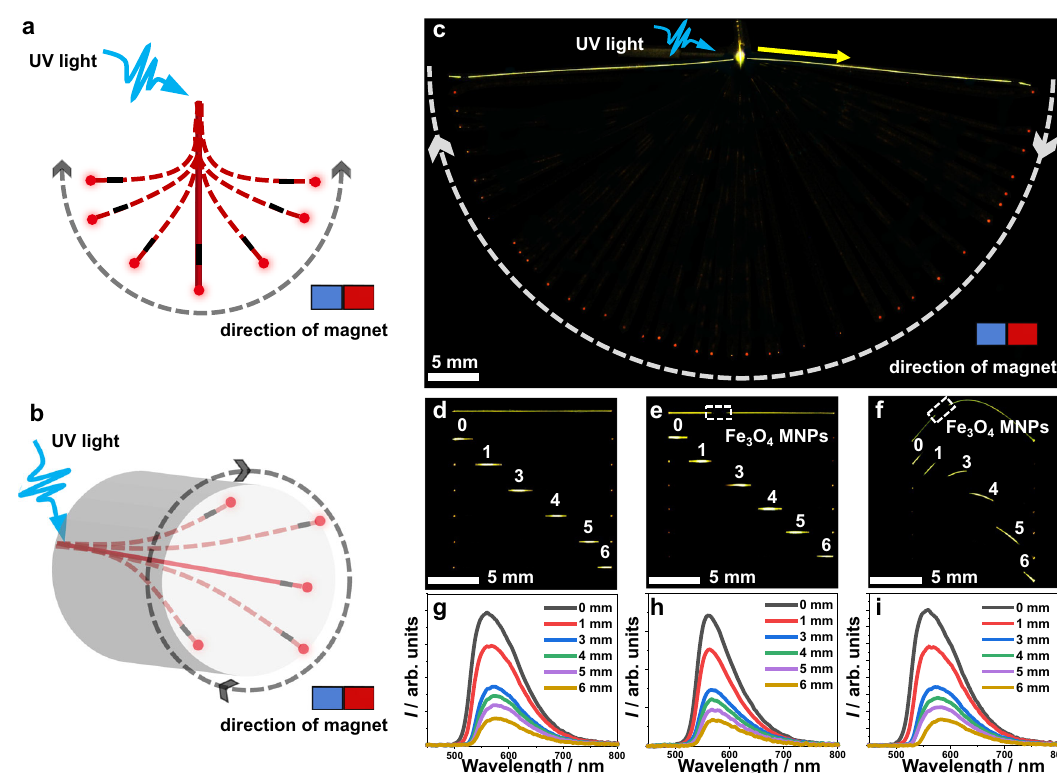
Fig. 4 Hybrid organic crystals as magnetically controllable organic crystal optical waveguides. a , b Schematic of the experiments that demonstrate control over the shape of a crystal as optical waveguide by using magnetic fi eld in two dimensions ( a ) and in three dimensions ( b ). The grey arrow represents the direction of movement of the magnet. c A crystal of MNP// 4 acting as magnetically controllable optical waveguide. One end of the crystal was af fi xed to the base while the other was free and its position was controlled by moving the magnet. The crystal was excited by a 355 nm laser light (blue arrow). The yellow arrow indicates the direction of light propagation, and the white arrow shows the motion of the magnet and the tip of the crystal. The red dot is the light output. Note that the contrast in this fi gure has been enhanced for clarity of inspection of the light output. d – f Images of the crystal of 4 used as a waveguide in uncoated the straight state, 4 ( d ), coated straight state, MNP// 4 ( e ) and coated bent state ( f ). g – i Fluorescence spectra collected at one tip of the crystal with different distances between the tip and the excitation site of the 355 nm light. The spectra in panels g, h and i correspond to the crystals shown in panels d, e and f,